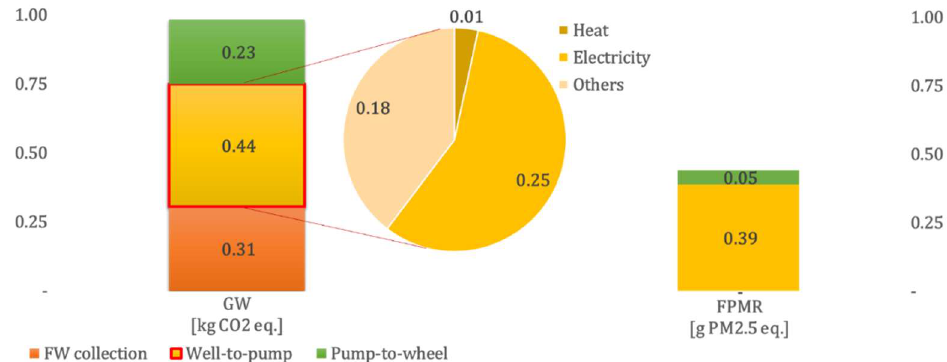
Figure 3. Environmental impacts (global warming (GW) and particulate matter formation (FPMR)) of the food waste (FW)-based green methane production and light-duty natural gas vehicle operation scenario (base case).